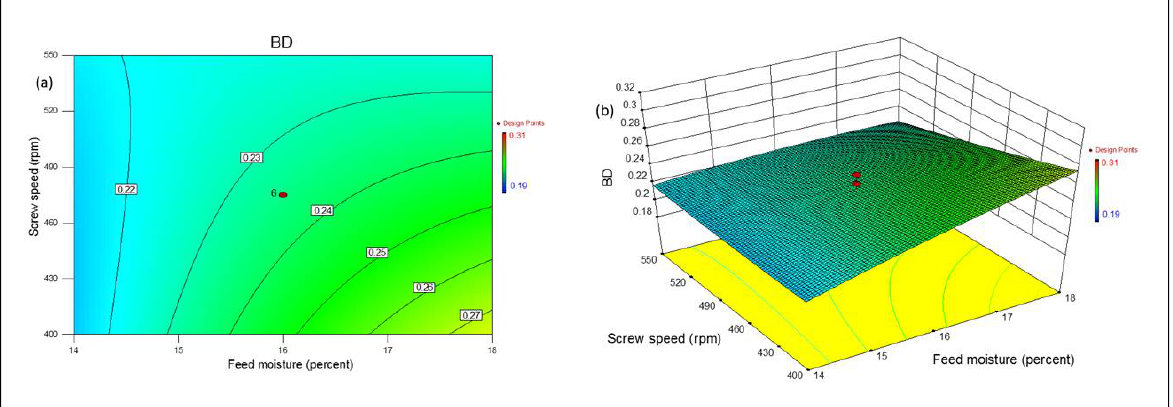
Figure 3: Contour (a) and its response surface (b) plot depicting the behavior of Specific mechanical energy(SME) at different feed moisture content and screw speed while the other processing variables are at center point